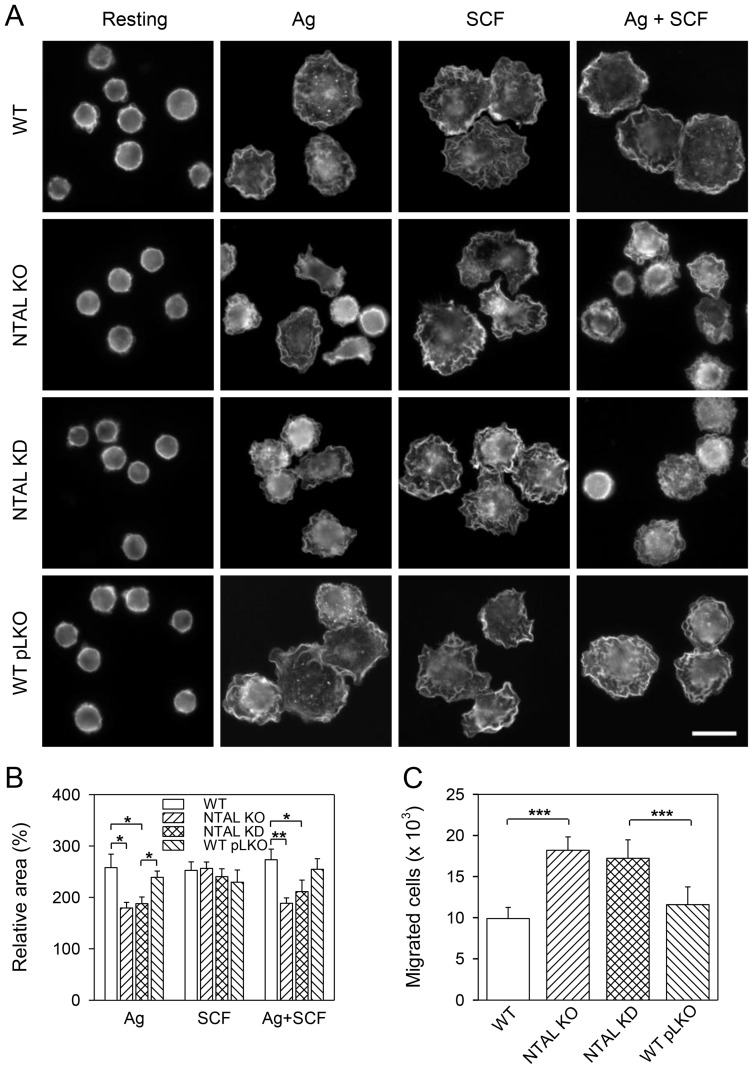
BMMCs with NTAL KD exhibit reduced spreading on fibronectin after stimulation with Ag or Ag + SCF, and enhanced chemotaxis towards Ag.(A) NTAL deficient cells and controls were sensitized with IgE, attached to fibronectin/Cell-Tak–coated glass for 1 hour at 37°C and then challenged or not (Resting) with Ag (250 ng/ml TNP-BSA), SCF (40 ng/ml) or both (Ag + SCF) for 30 minutes. Afterwards the cells were fixed and stained for actin with Alexa Fluor 488 phalloidin. Scale bar 10 µm. All images are depicted in the same scale. (B) Cell areas were determined using ScanR analysis software and data were normalized to nonactivated cells. Means ± SE were calculated from 6 independent experiments with at least 500 cells evaluated in each test. (C) Chemotactic response of IgE-sensitized BMMCs (WT, NTAL KO, NTAL KD and WT pLKO) towards Ag (250 ng/ml TNP-BSA) was evaluated by means of Transwell system with polycarbonate membrane. Numbers of the cells migrating through the membrane after 8 hours were determined by flow cytometry. Means ± SD were calculated from 4 independent experiments performed in duplicates. *p<0.05; **p<0.01; ***p<0.001.